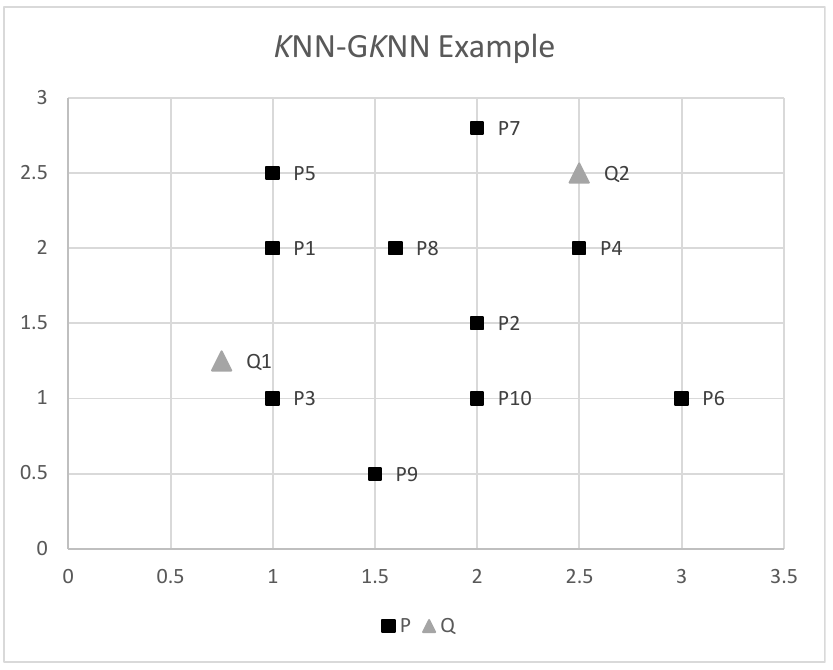
Figure 1. K NN-G K NN